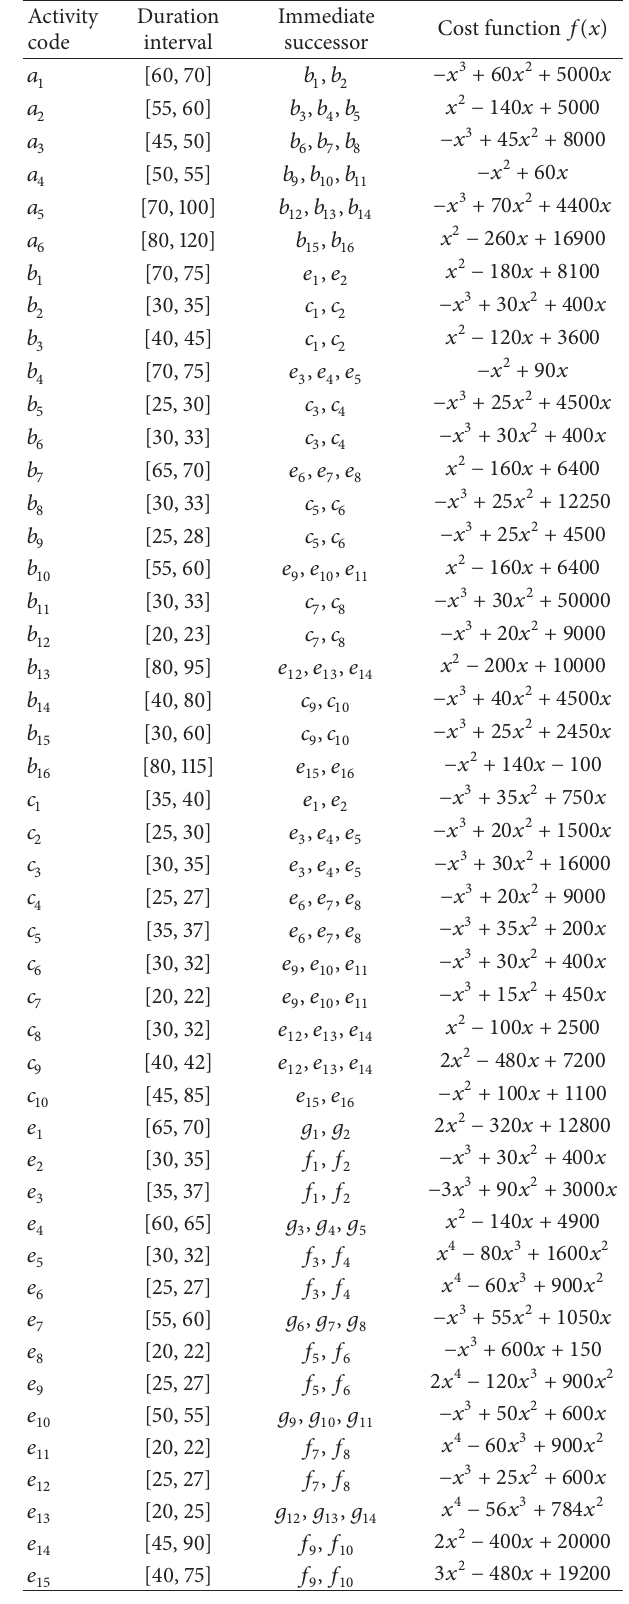
Table 1: The information of each